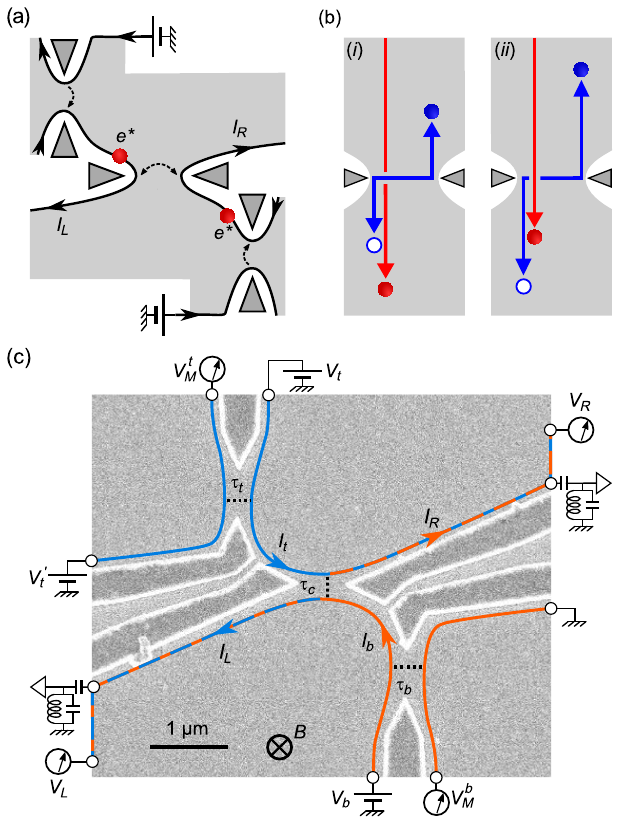
FIG. 1. (a) Source-analyzer setup. Quantum point contacts (pairs of facing triangles) at the top left (QPC ) and bottom right t (QPC ) in the weak backscattering (WBS) regime constitute b sources of quasiparticles of fractional charge e (cid:2) . The emitted quasiparticles propagate toward the central analyzer QPC along c quantum Hall edge channels depicted by lines with arrows δ I (inactive channels not shown). Cross-correlations h δ I in- L R i form on the statistics. (b) Braid-induced mechanism. Analyzer tunnelings [double arrow in (a)] result from interferences between the generation of a quasiparticle-quasihole pair across QPC c (blue double arrow) after (i) or before (ii) the passing of incident quasiparticles (one represented with a red arrow). The process cancels for a trivial braid phase 2 π . (c) Sample e -beam micro- graph. Metallic gates on the surface of a Ga(Al)As heterojunction appear darker with bright edges. QPC are tuned to matching t;b ≈ τ of the active channel. The source transmission ratios τ t b − I − V 0 imbalance I − ≡ I is controlled with V . We set V 0 t b t b t ¼ except for the separate shot noise characterization of the central analyzer QPC , which is performed with a direct voltage bias c 0 V ( V 0 and V t ¼ t b ¼